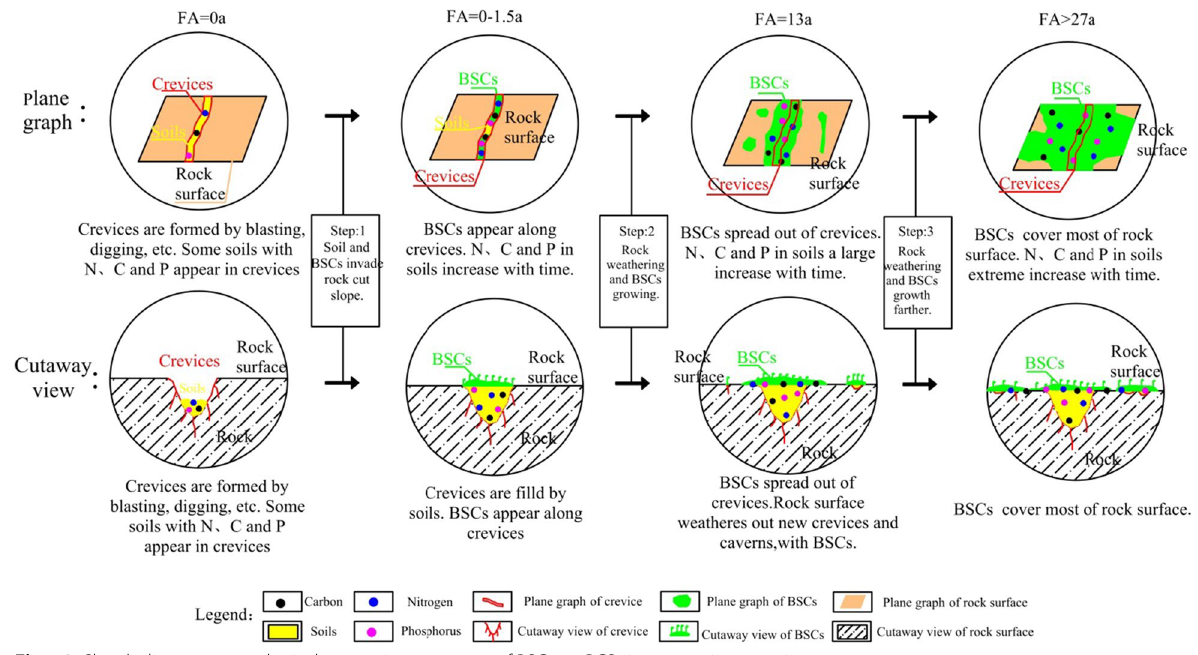
Fig. 10 Sketch diagram on ecological restoration processes of BSCs on RCSs in mountainous